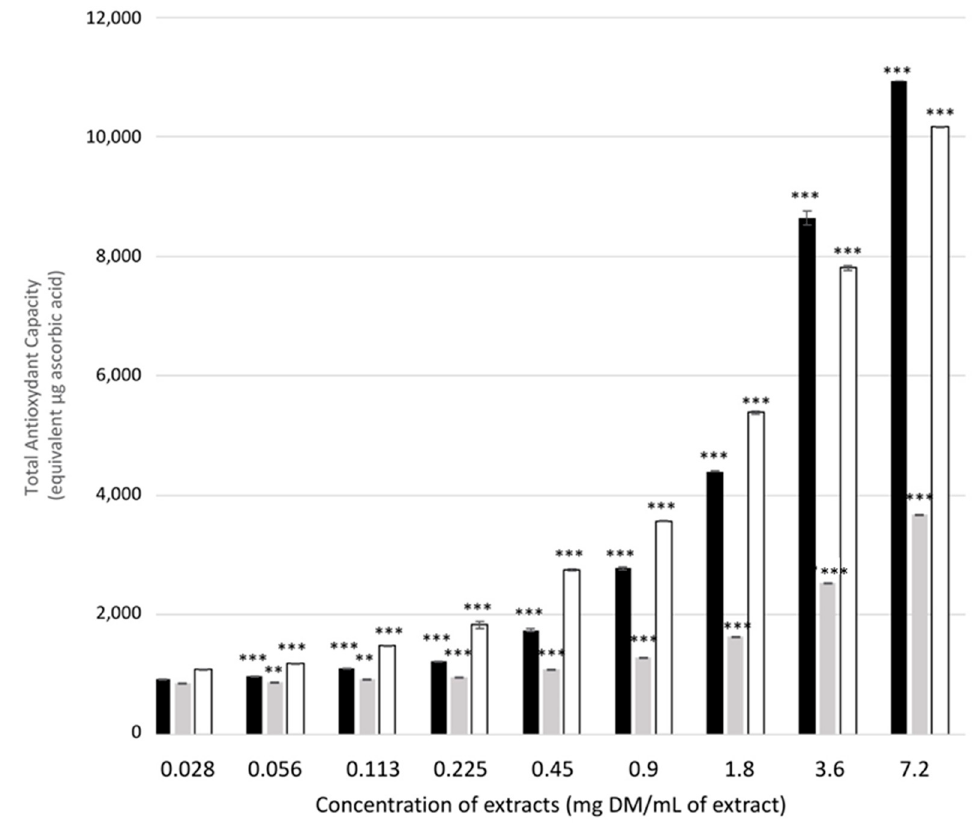
Figure 3. Total antioxidant capacity of the three plant extracts measured by phosphomolybdenum reduction and expressed in µg ascorbic acid equivalents. Mate: black bars, rosemary: grey bars, green tea: white bars . Shown are the means of six replicates +/ − SD. Significant differences between the different concentrations of the same plant extract are indicated by ** for p -value < 0.01 and by *** for p -value < 0.001.